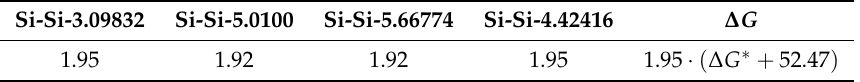
Table 2. Average breakage value for each bond for the quartz grain example and ∆ G ∗ and ∆ G